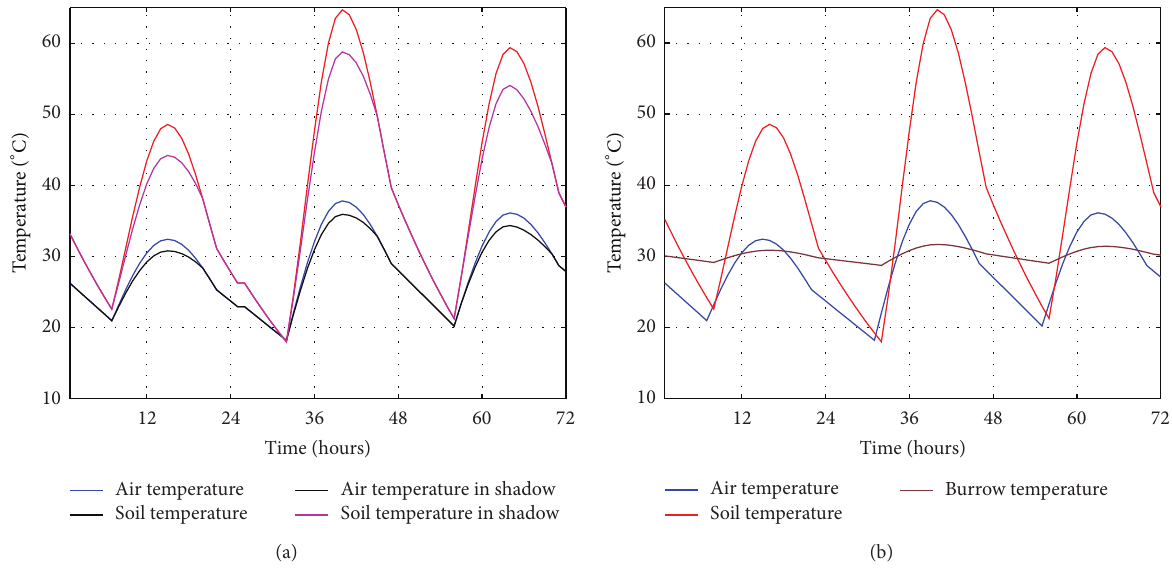
Figure 5: Simulated temperatures for three days in different conditions.